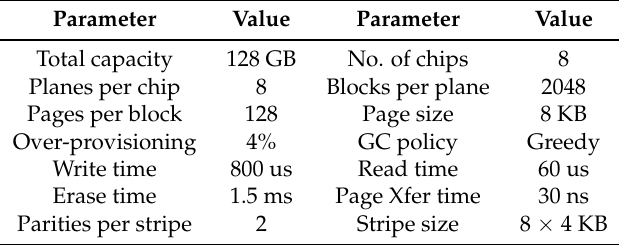
Table 1. Parameters of Solid State Drives (SSD) Simulator.